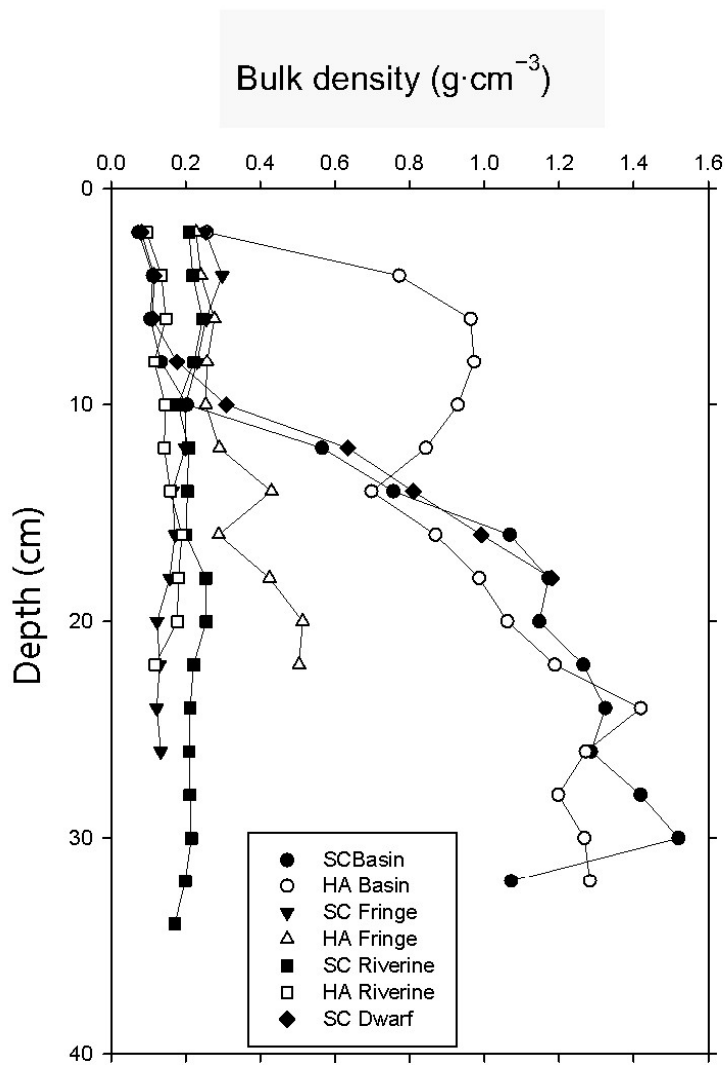
Figure 2. Average bulk density (g ¨ cm ´ 3 ) for the past 50 years within soils located in seven different mangrove sites in different hydrogeomorphic settings in the hydrologically disturbed Hamilton Avenue Creek (HA) and the reference Susan’s Creek